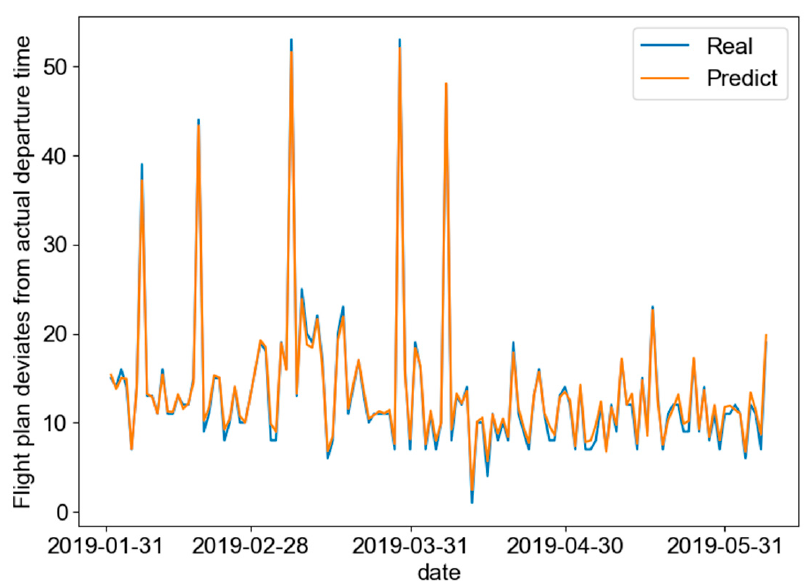
Figure 6. The fitting effect of the training set after adding the early stopping strategy.